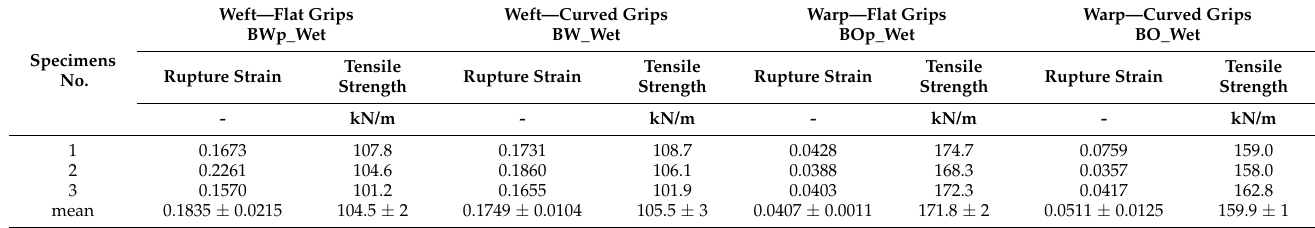
Table A5. Elongation at break and tensile strength—wet B-type fabric.